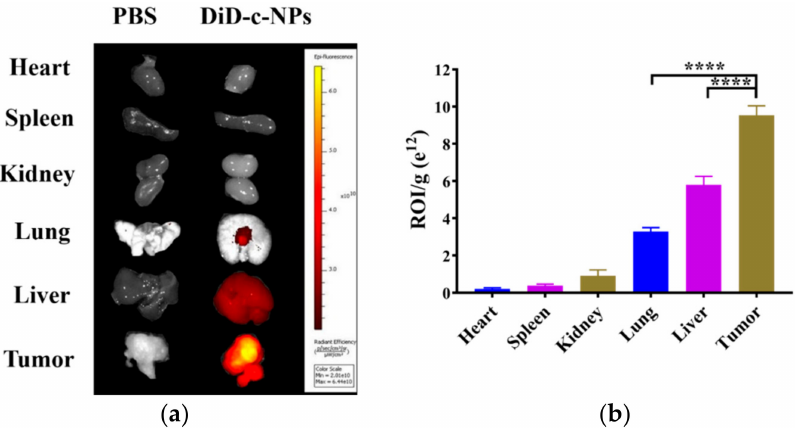
Figure 5. ( a ) Tissue distribution in tumor-bearing mice after injection DiD-c-NPs, and observed by in vivo imaging system, n = 3; ( b ) Region-of-interest (ROI) fluorescence intensities of tumors and major organs, **** p < 0.0001.